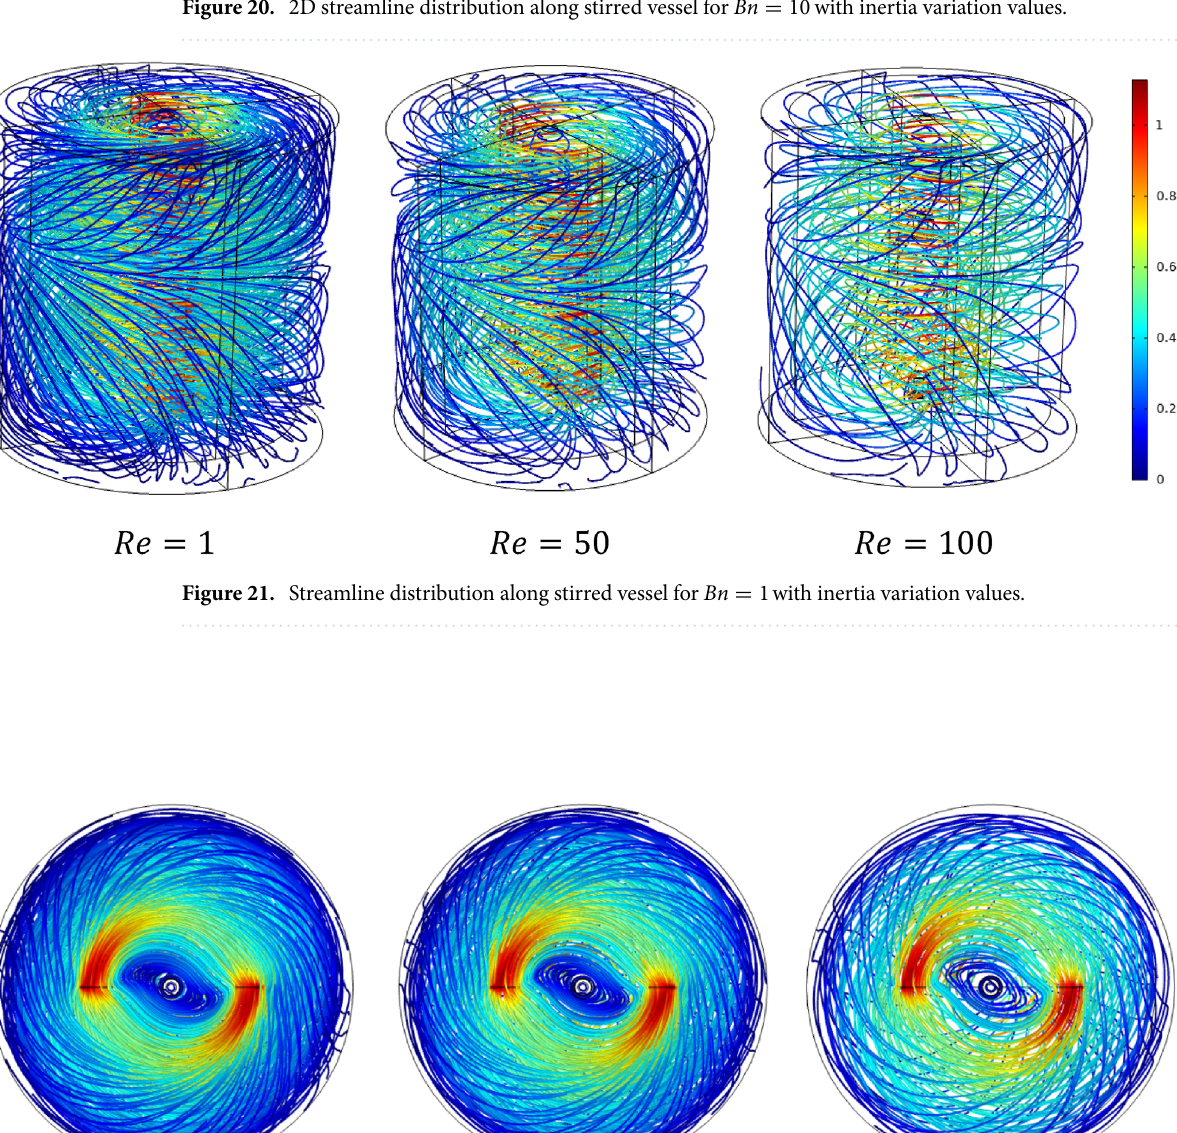
Figure 20. 2D streamline distribution along stirred vessel for Bn = 10 with inertia variation values.